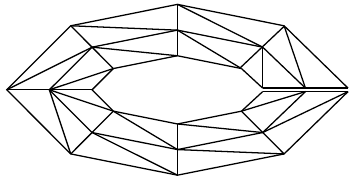
Figure 3. Mesh h of Ω i for Example 1. Figure 3. Mesh ℎ of Ω (cid:3036) for Example 1. Table 1. The errors against mesh for Example 1 ( µ 1 = 2, N = 20). Table 1. The errors against mesh for Example 1 (𝜇 (cid:2869) = 2, 𝑁 = 20) . Mesh